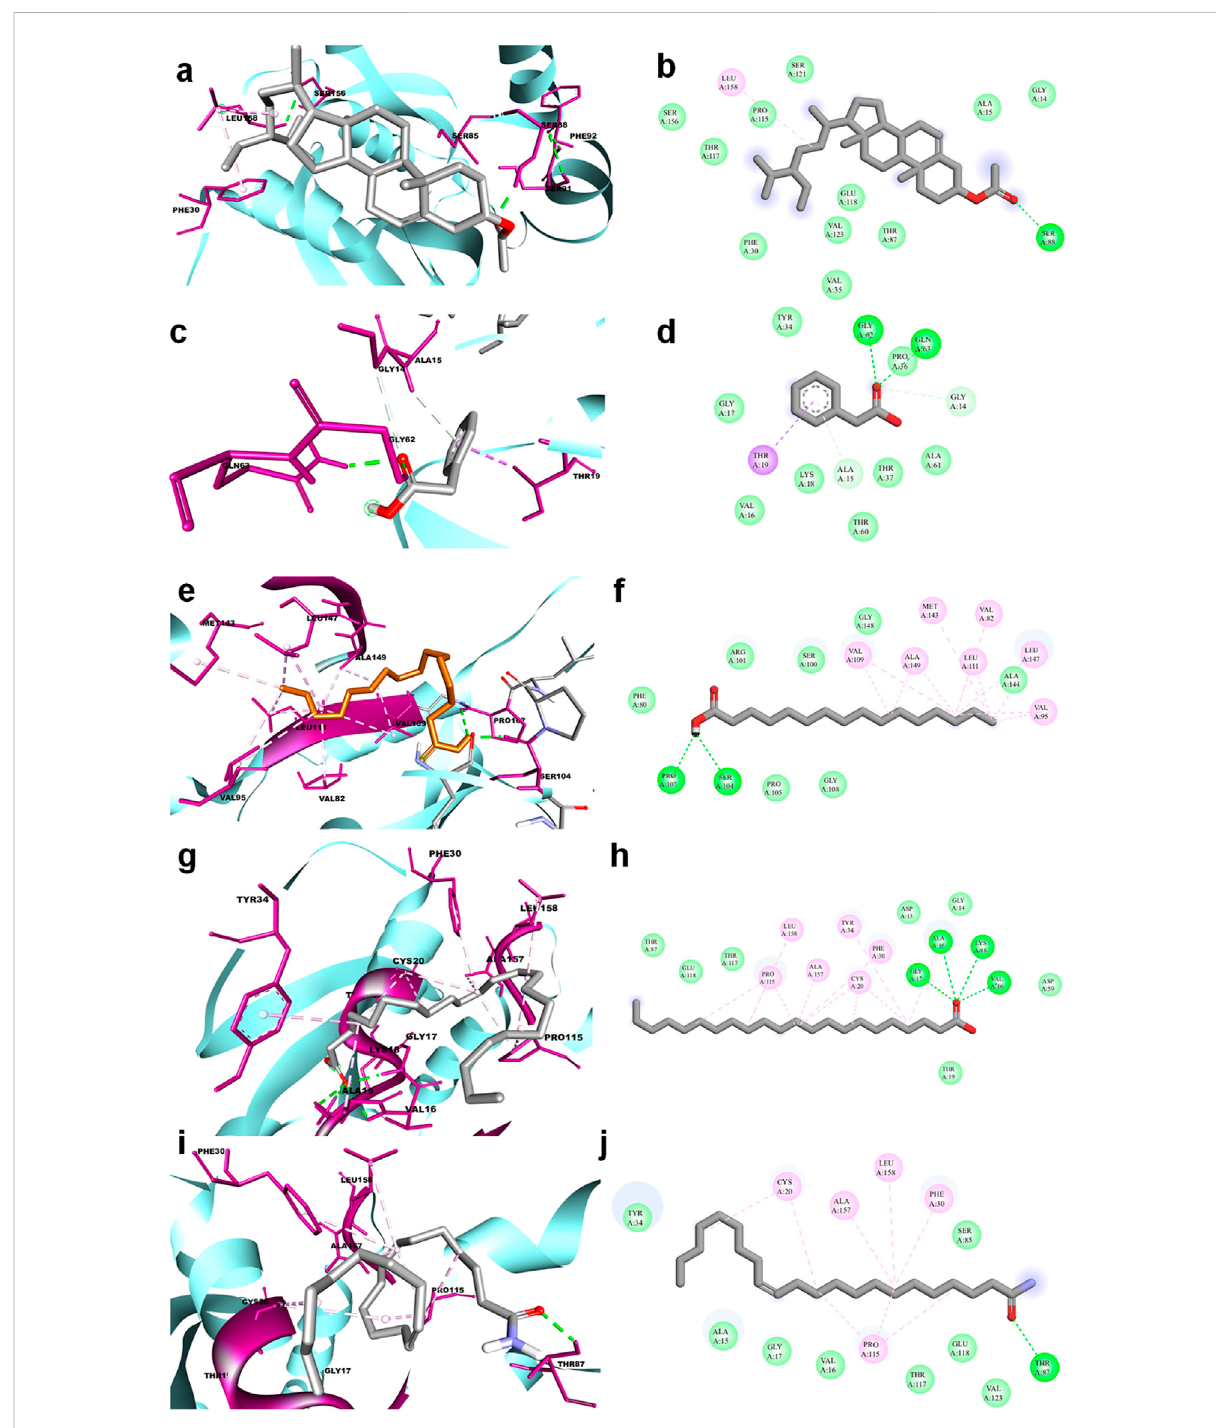
FIGURE 2 3D and 2D representation of molecular docking of CDC42 with ligands from B. megaterium . The ligands and their interaction are shown with the line diagram. The color code green color represents the hydrogen bond. Purple color represents pi-sigma interaction. Light pink color represents, pi-alkyl and alkyl interaction. (A,B) = beta sitosterol, (C,D) = Phenylacetic acid, (E,F) = palmitic acid, (G,H) = Behenic acid and (I,J) =